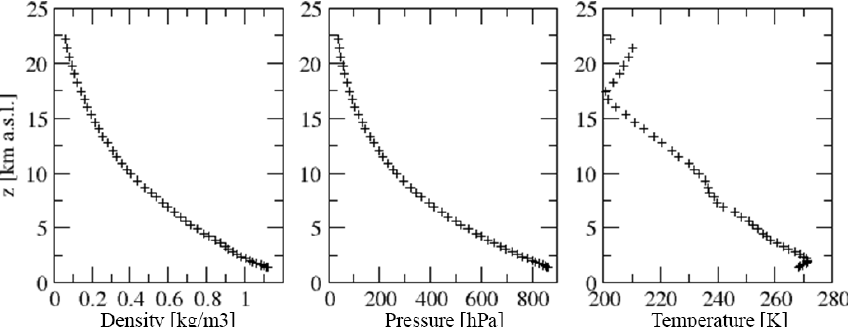
Figure 16. Atmospheric profiles as provided by the Japanese Meteorological Agency’s Non-Hydrostatic Model (Hashimoto et al., 2012) for Shinmoe-dake volcano at 00:00JST on 27 January 2011.